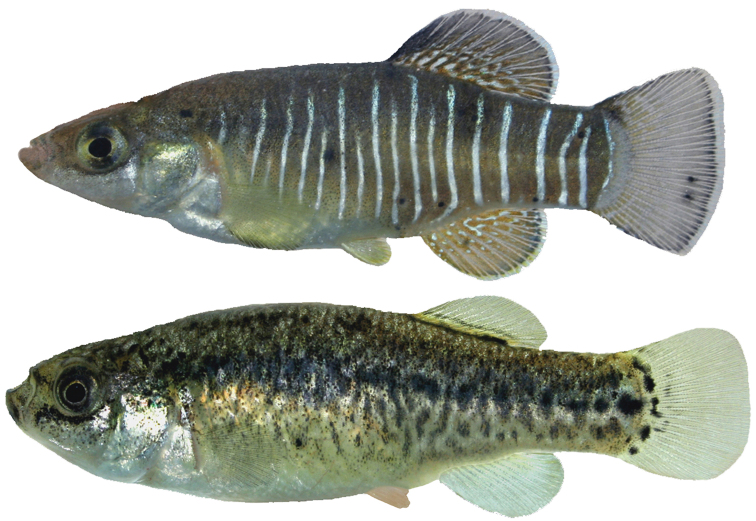
Male (above) and female specimens (not preserved) of Aphanius arakensis sp. n., collected from Cheshmeh Nazi (Nazi spring, 33°42'56.8"N, 50°04'21.9"E) near type locality, Namak Lake Basin.